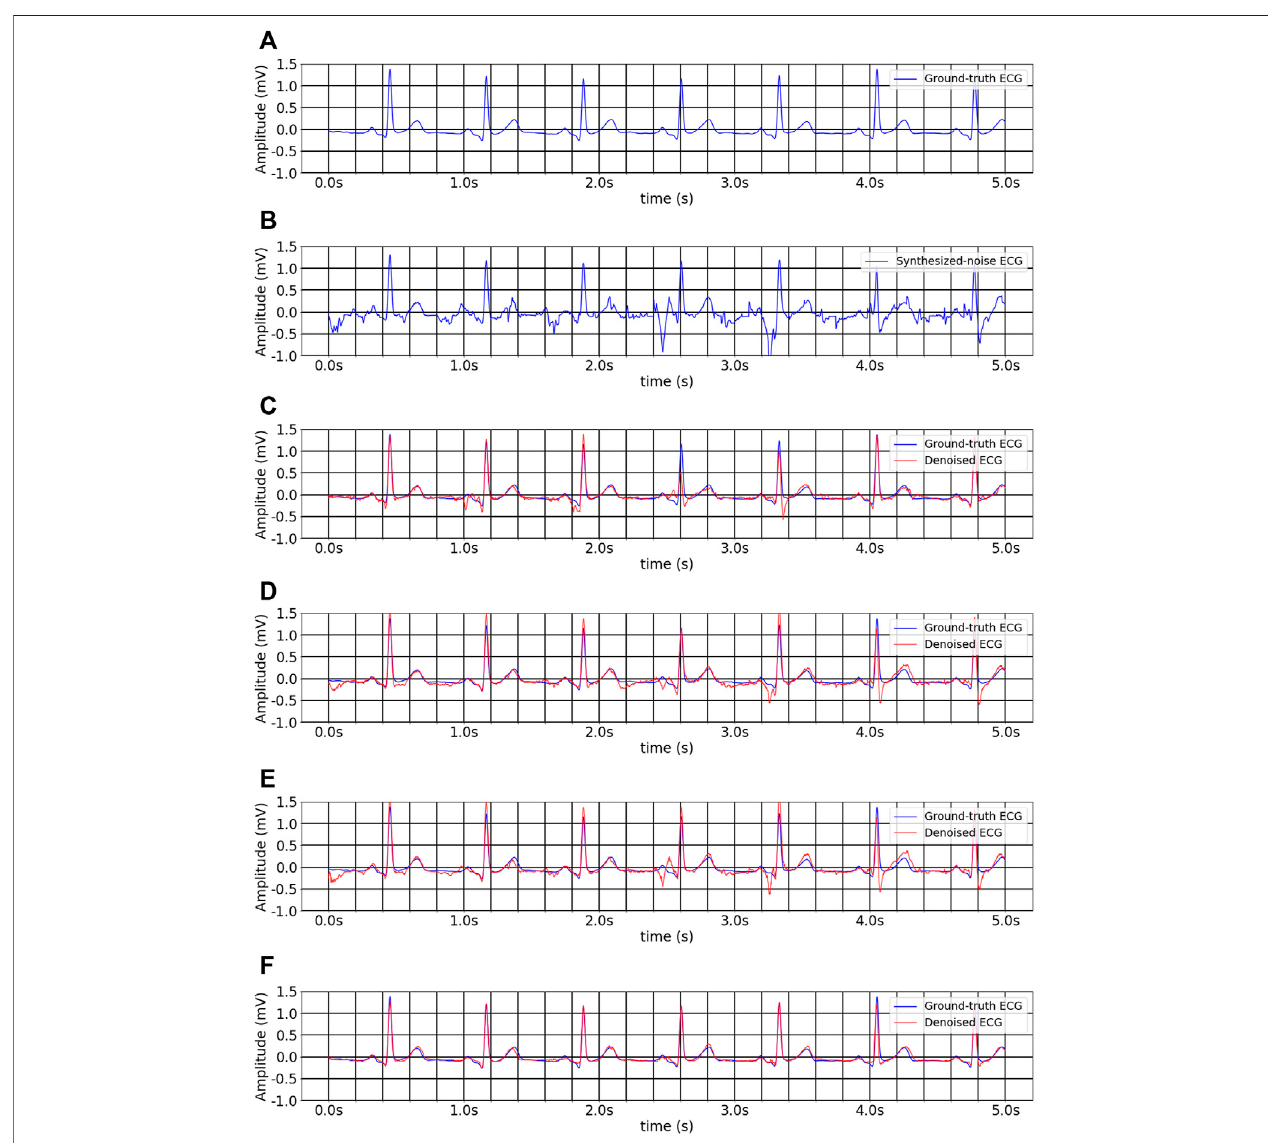
FIGURE 6 | The inter-analysis denoising results of different methods on multitask inheritance training scheme. (A) Ground-truth ECG. (B) Noise-convolved ECG. (C) Denoised ECG by 1D CNN Unet. (D) Denoised ECG by FCN. (E) Denoised ECG by Unet_LUDB. (F) Denoised ECG by EBTnet.